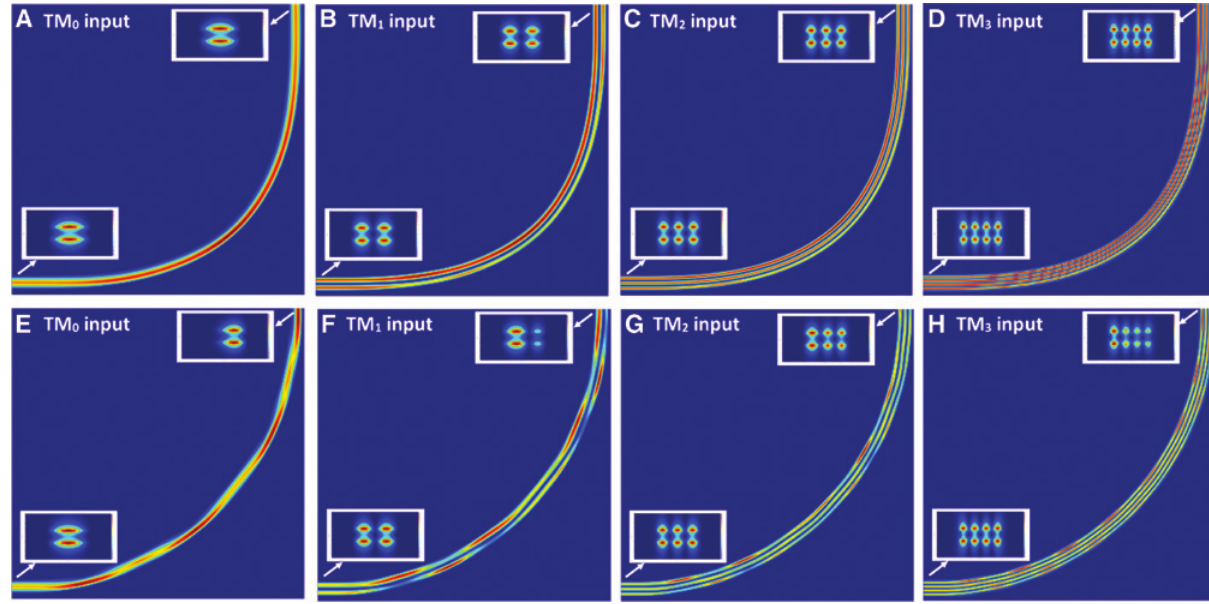
= 45 μ m (A–D) and a regular arc-bend with R = 45 μ m (E–H) when eff